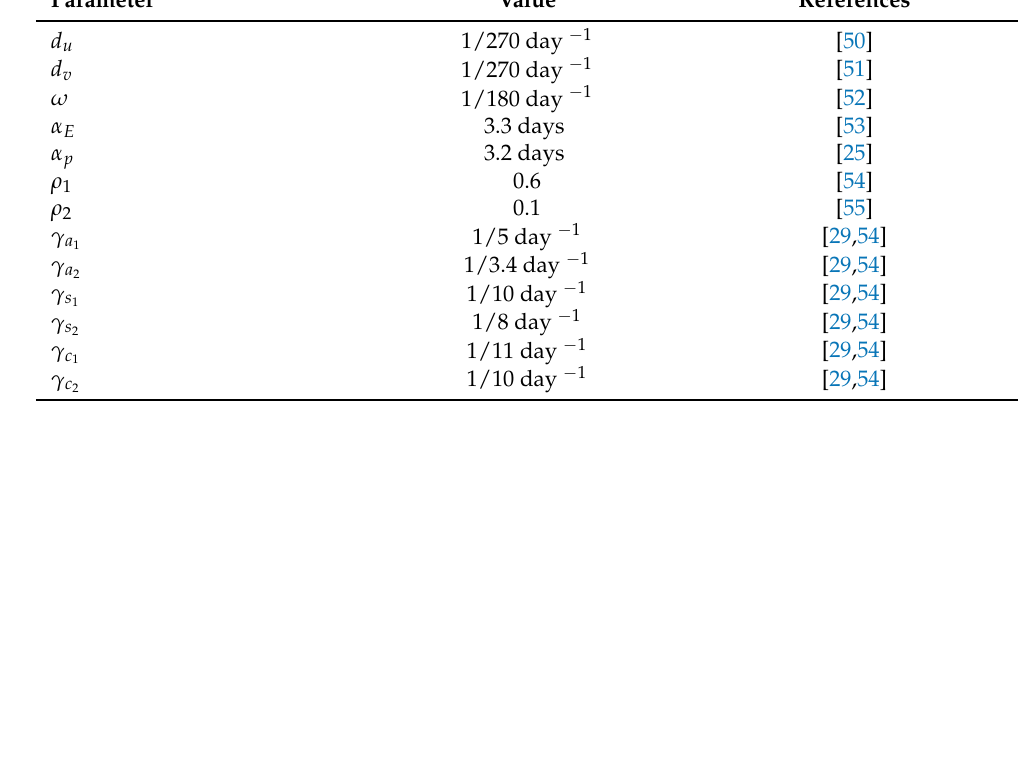
Table A2. Fixed model parameters, their description and value.